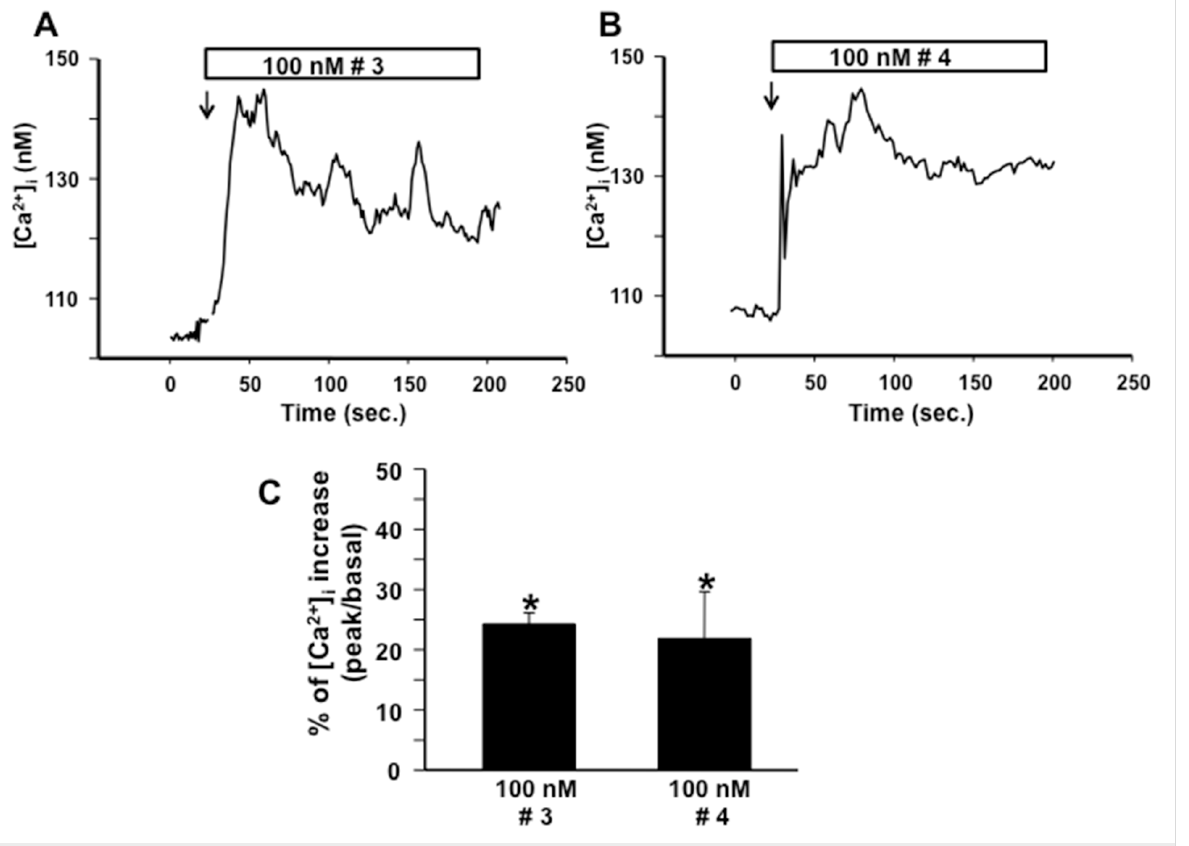
Figure 3: Effect of 3 and 4 on intracellular [Ca 2+ ] in NGF-differentiated PC12 cells. (A) and (B): representative single-cell traces of the effect of 3 and 4 (100 nM) on [Ca 2+ ] i ,. (C): quantification of [Ca 2+ ] i increase calculated, after the addition of each compound, as the percentage change of plateau/ basal value. Each bar represents the mean (±S.E.M.) of the values obtained in three independent experimental sessions. For each experiment, 10 to 40 individual cells were monitored. *, P < 0.05 versus basal